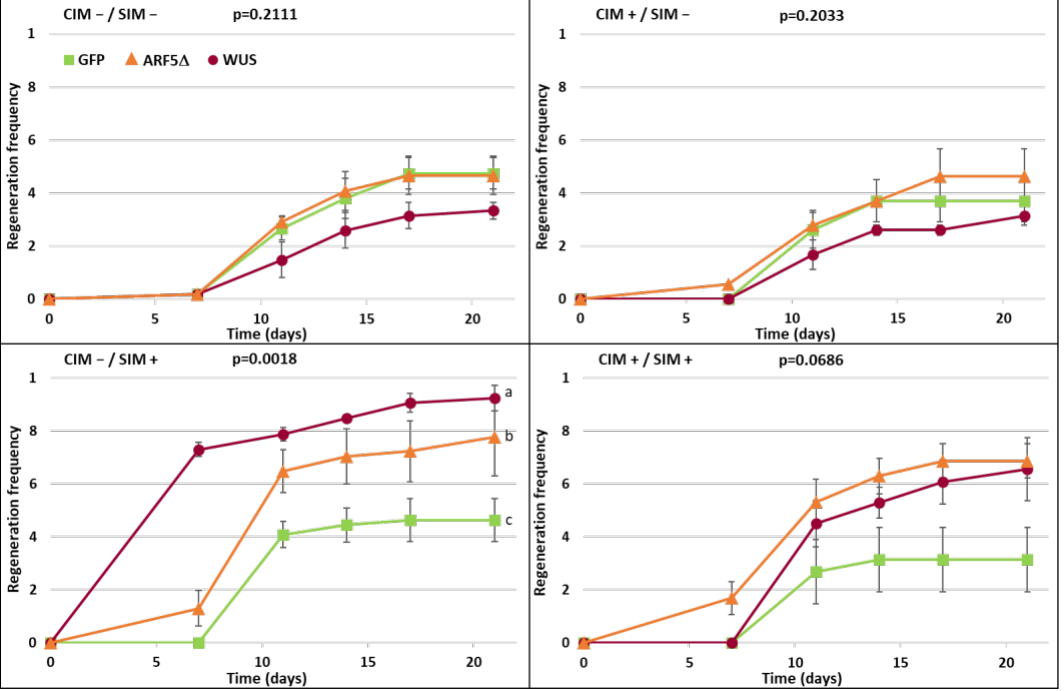
Figure 3. Efficiency of shoot regeneration in plants expressing GFP , WUS, or ARF5 ∆ . Root segments from one-week-old seedlings of plants carrying XVE:GFP, XVE:WUS, or XVE:ARF5 ∆ were induced to form shoots by transfer to CIM for one week followed by transfer to SIM for three weeks. CIM/SIM were supplemented with 0.1 µ M β -estradiol (+) or equivalent volume of vehicle as a control ( − ). Regeneration was measured as the fraction of explants forming shoots over the three weeks on SIM. The p value for a one-way ANOVA of the area-under-the-curve comparing overexpressed genes is presented for each treatment. Error bars indicate standard error of the mean and letters indicate homogeneous subsets in post hoc testing using the Holm method ( p < 0.05), n = 3.